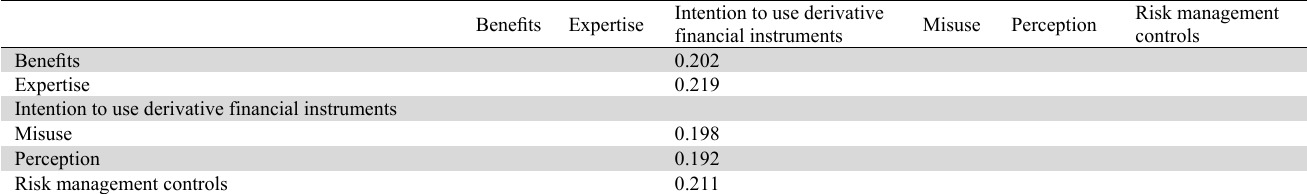
The results of F-Square